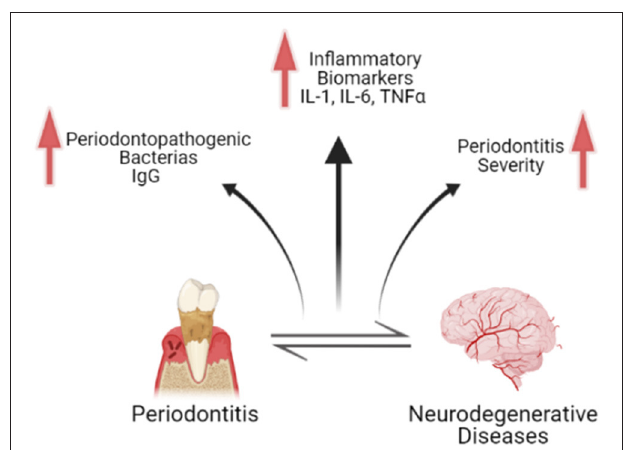
FIGURE 2 | Schematic figure representing the main findings regarding the association between periodontitis and neurodegenerative diseases. The bidirectional relationship between both conditions is associated with the increase of inflammatory biomarkers, increase in immunoglobulins G related to periodontopathogenic bacteria, and increase in periodontitis severity. Schematic figure created with